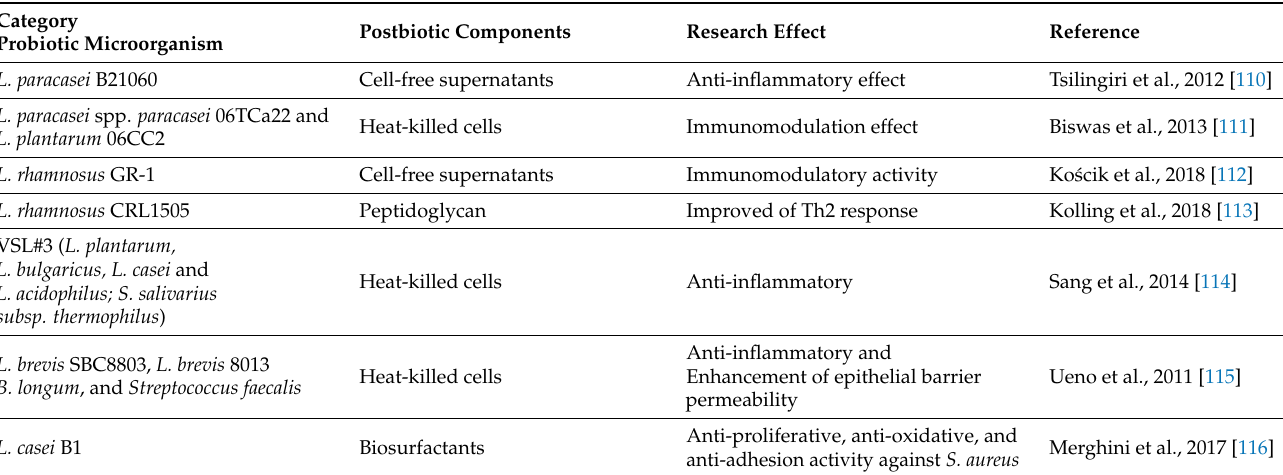
Table 2. Effect of immunomodulation by selected